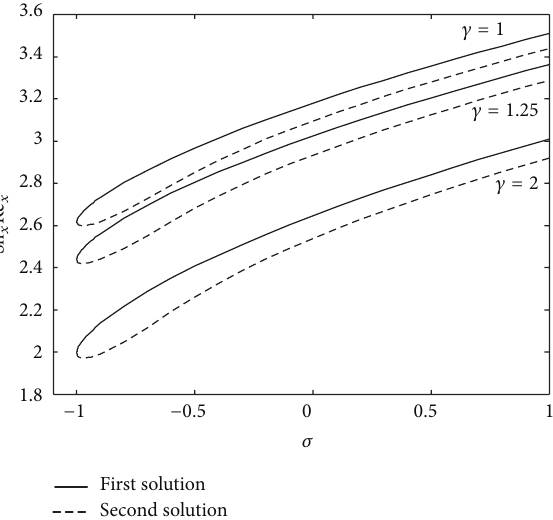
Figure 3: Variations of the local Nusselt number (heat transfer rate) with 𝜎 for different values of Nt when Nb = 0.5, Le = 2, Pr = 6.8, 𝛾 = 0.1, and S = 2.